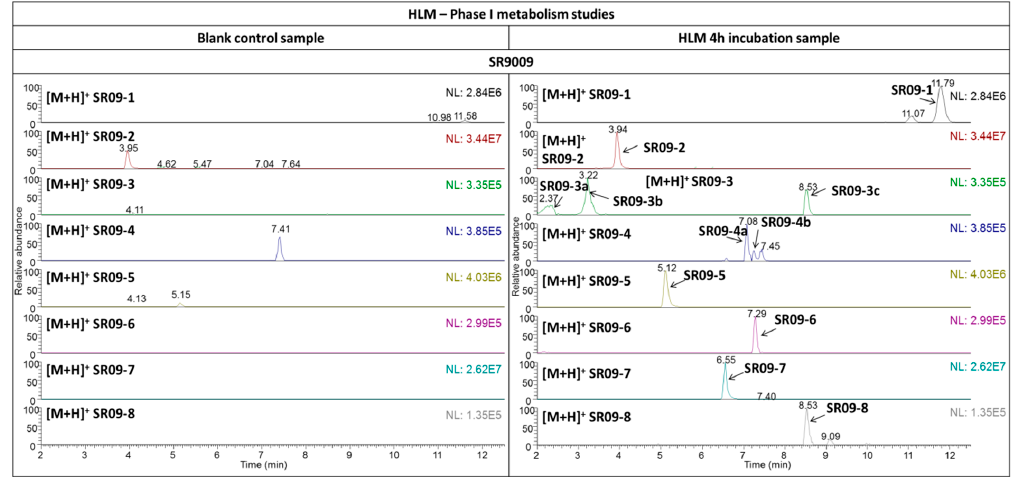
Figure 2. In vitro metabolic studies with SR9009. The extracted ion liquid chromatography–high resolution mass spectrometry (LC–HRMS) chromatograms of the 4-h human liver microsomes (HLM) incubation samples ( right column ) are presented in comparison with blank (without HLM) control samples ( left column ). NL: normalization.